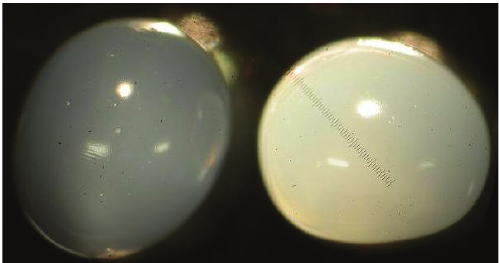
Figure 1: Pictures of Alg-Ca (left) and CAP (right) prepared with 0.8% AP.